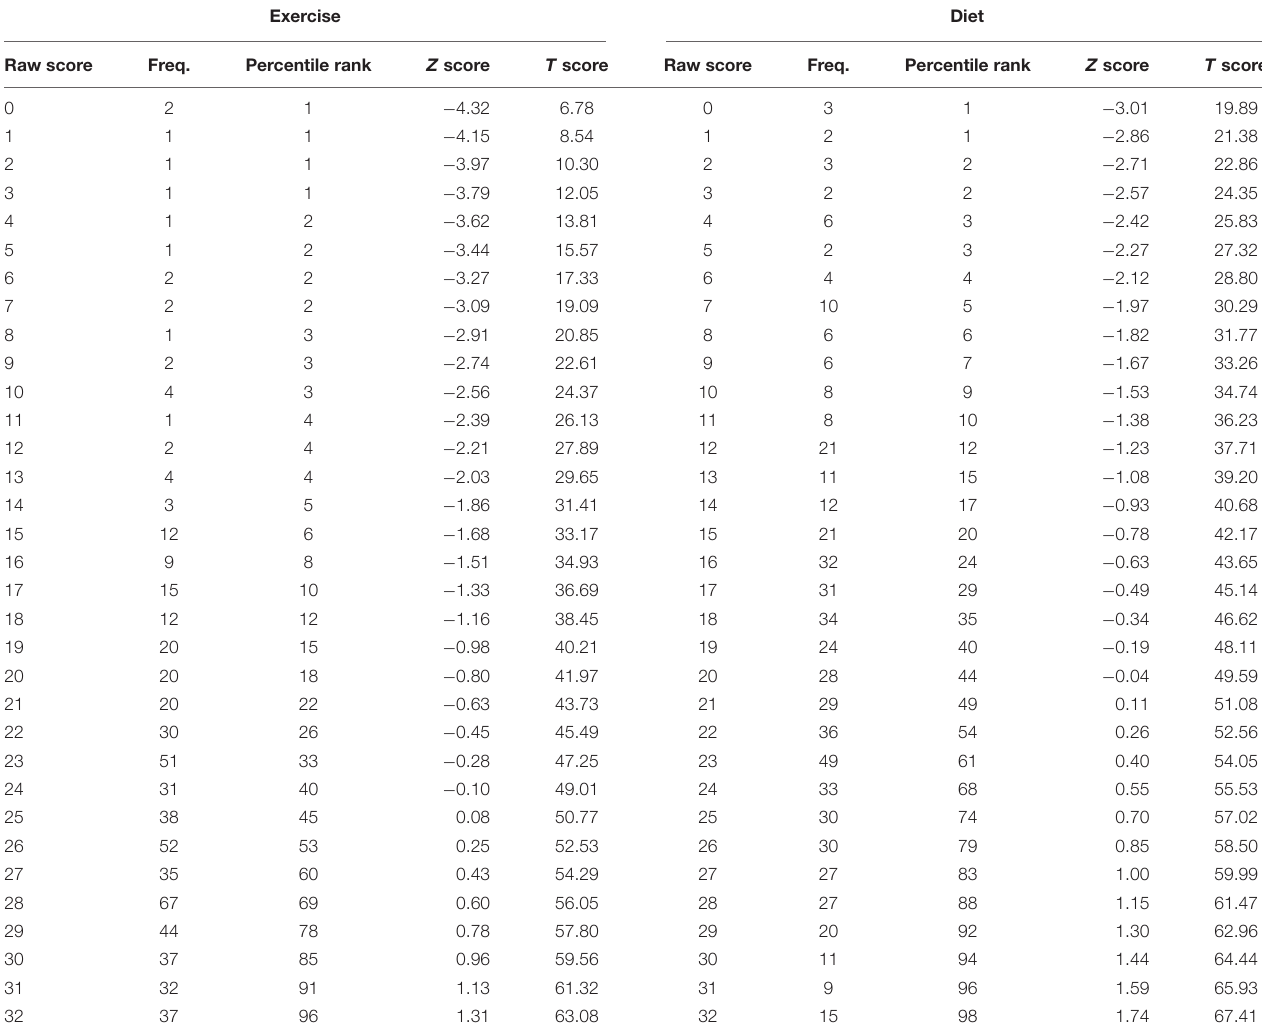
TABLE 6 | Raw scores, frequencies of the raw score, percentiles of the distribution of the raw score, Z scores and T scores for motivation to exercise and diet scales. Exercise Diet Raw score